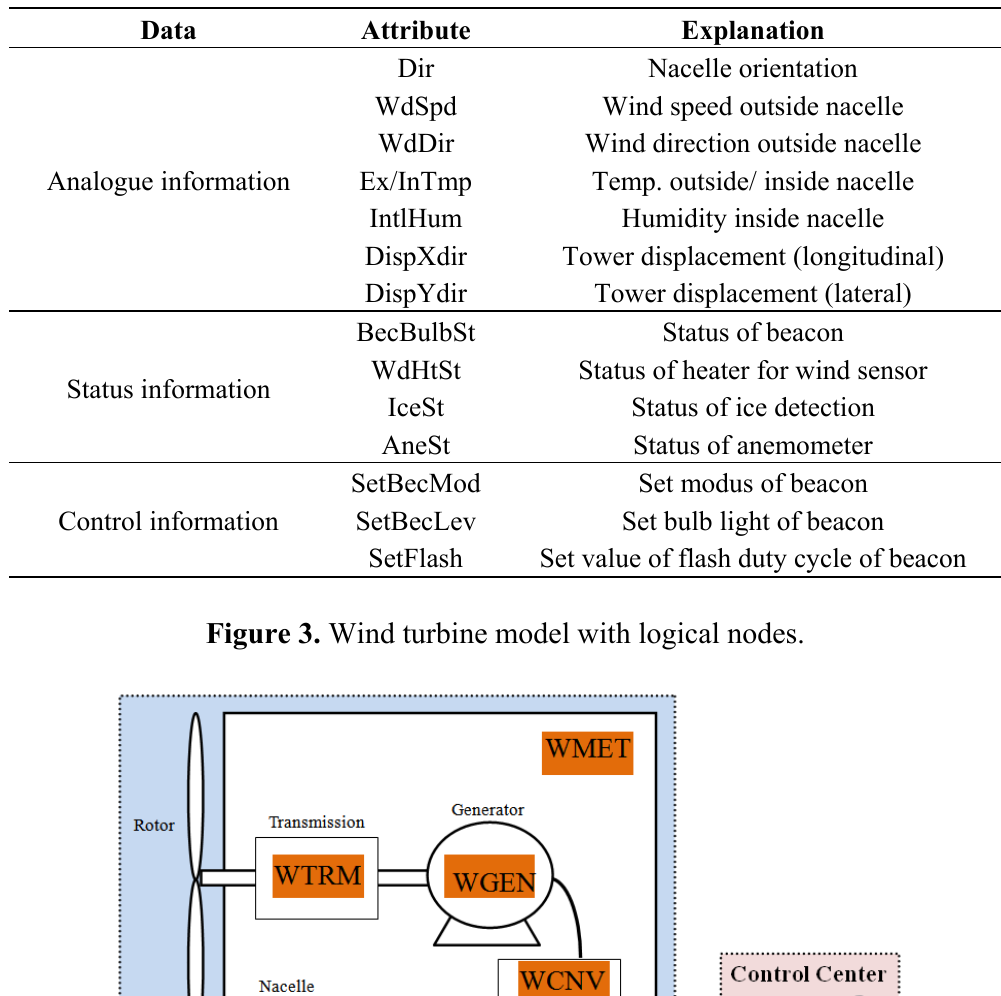
Table 2. Types of data and attributes in wind turbine nacelle.